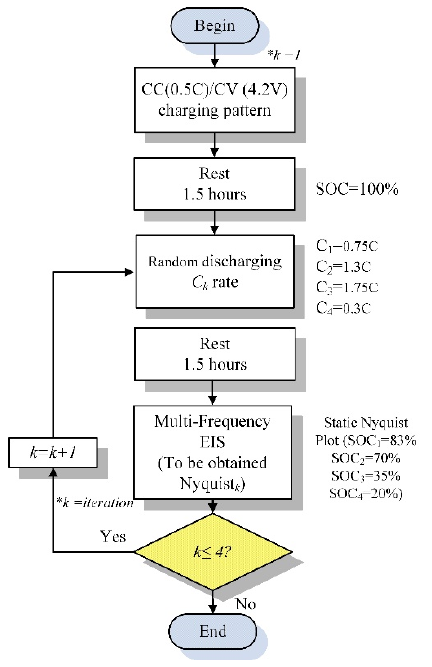
Figure 7. Experiment flowchart to validate the ANN-based model.